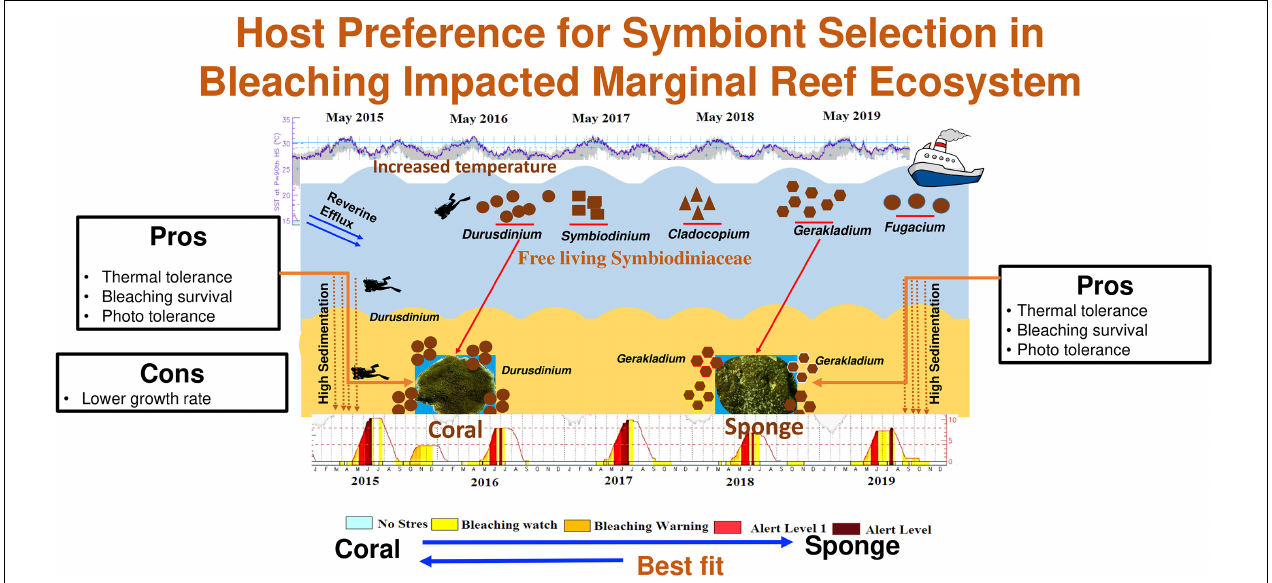
FIGURE 6 | Graphical representation of host-specific acquisition of Symbiodiniaceae and its benefit to the host survival in bleaching impacted marginal coral reef ecosystem.